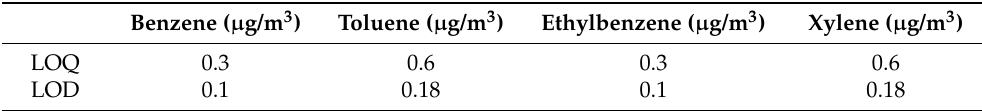
Table 1. LOD and LOQ limits in this study for the BTEX compounds .